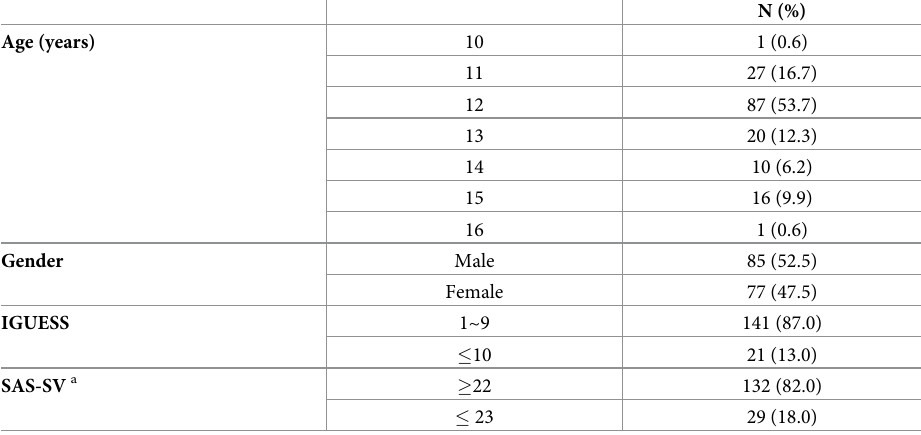
Table 1. Demographic characteristics of the participants.